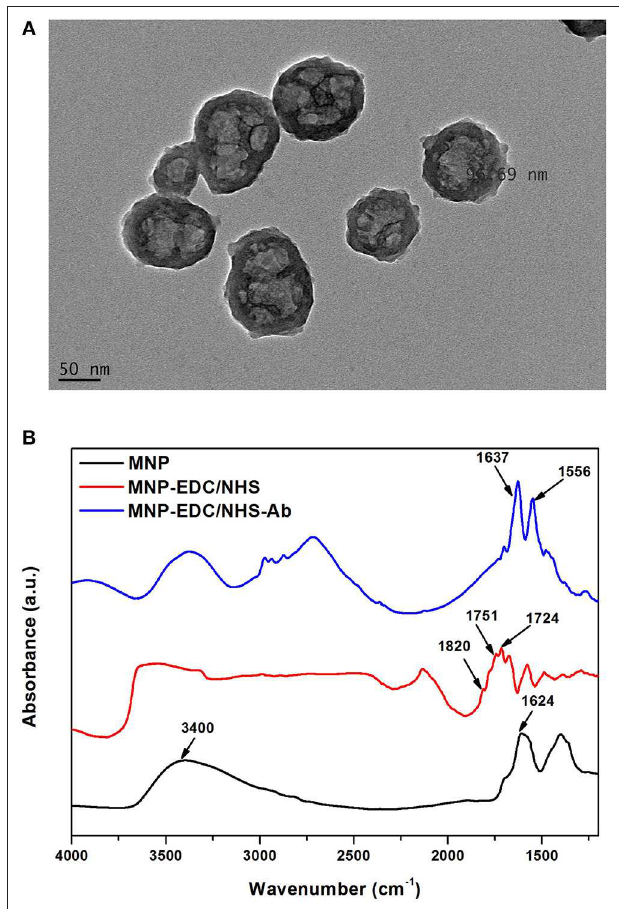
FIGURE 1 | TEM characterization of MNPs (A) , and FTIR spectra of MNPs at different modification steps: unmodified MNPs (black) after EDC/NHS activation (red) and after Ab2 immobilization (blue) (B)